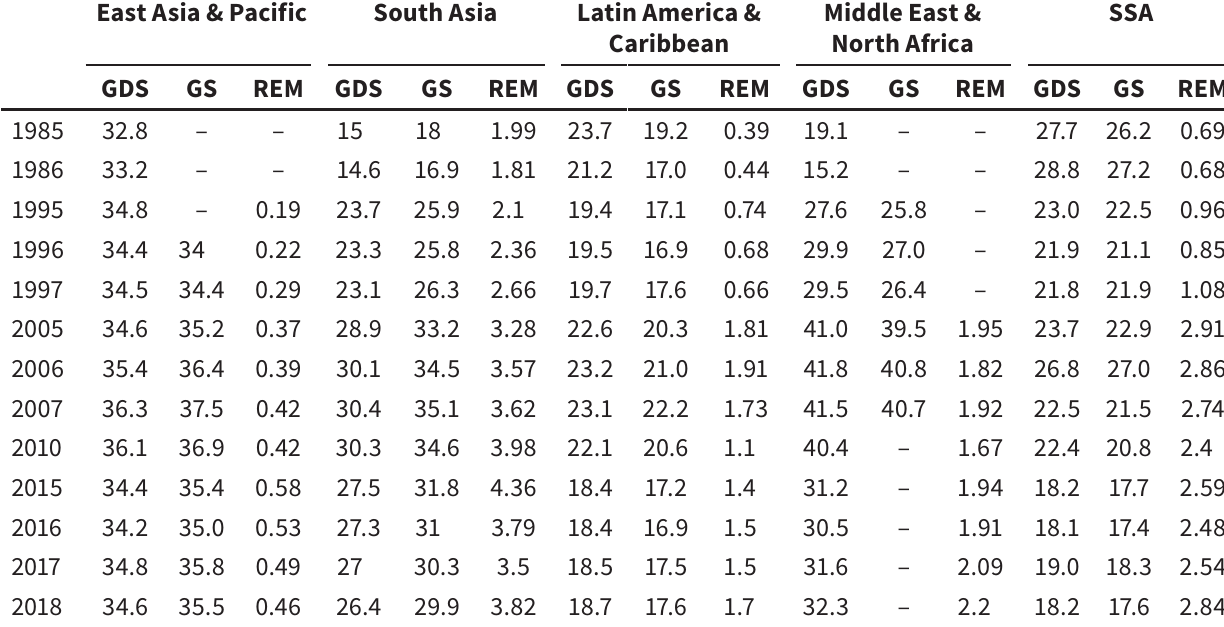
Middle East Caribbean